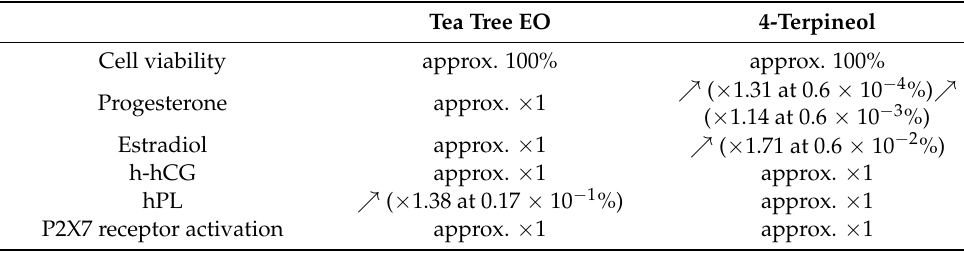
Table 4. Summary of the results of tea tree EO compared to 4-terpineol. Tea Tree EO 4-Terpineol Cell viability approx. 100% approx. 100% Progesterone approx. ×